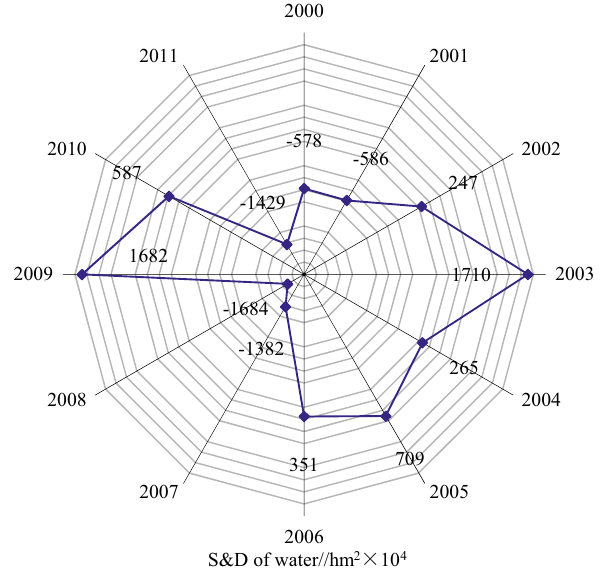
Fig. 7 Ecological surplus (deficit) in Heilongjiang